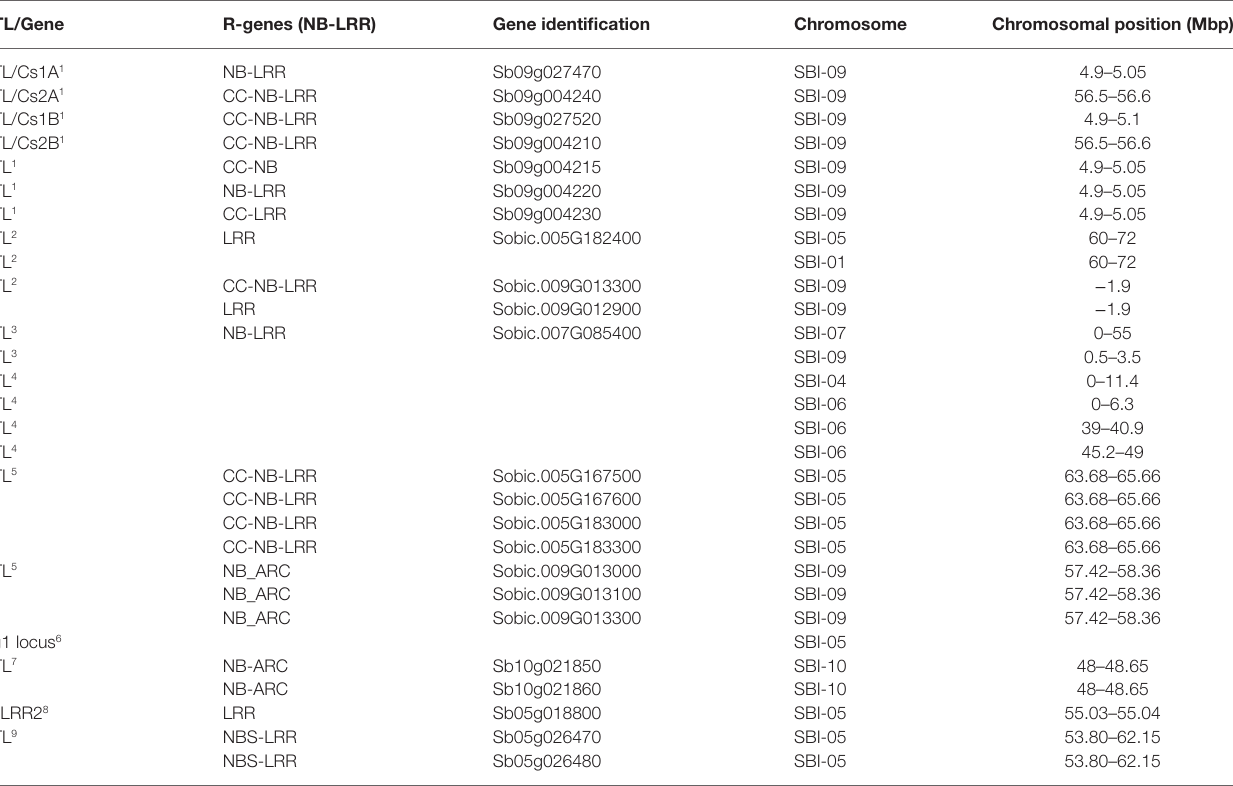
TABLE 1 | The list of quantitative trait loci (QTL) and NB–LRR genes identified in sorghum genotypes responding to anthracnose infection. QTL/Gene R-genes